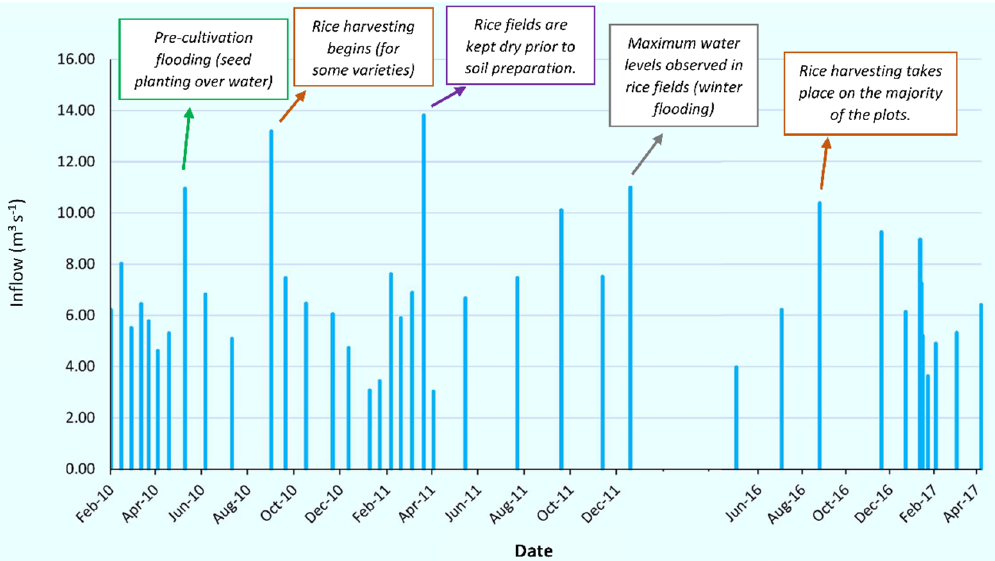
Figure 6. Total inflow to the Albufera Lake recorded on each of the sampling dates between the periods 2010–2011 and 2016–2017 together with some indications about rice cultivation and field condition considered relevant.